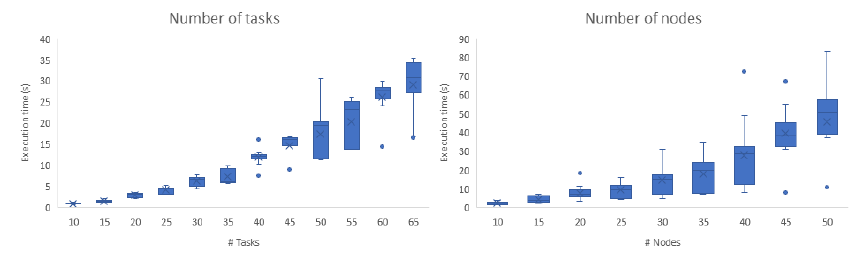
Figure 5. Time execution according to the number of tasks and